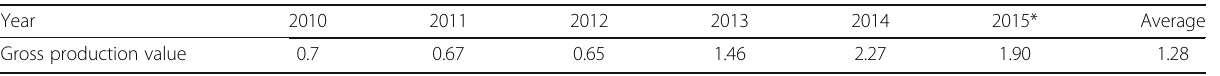
Table 6 Beeswax gross production value in US$(billion)